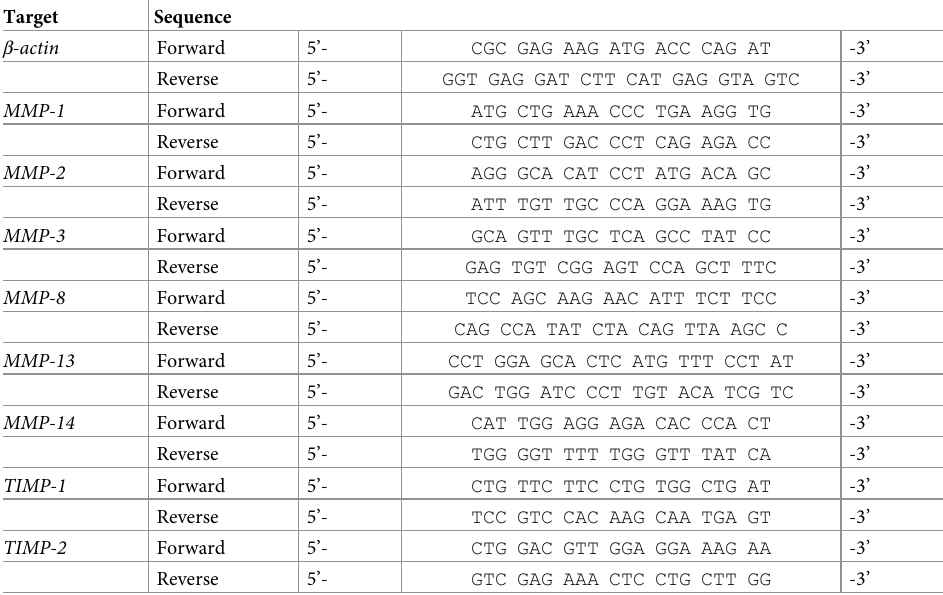
Table 1. List of primers for real-time quantitative